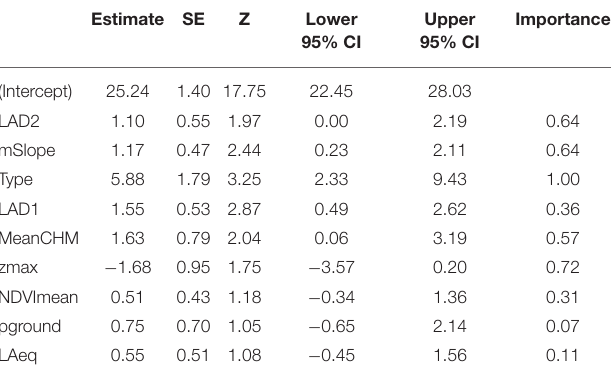
TABLE 6 | Model Averaged Coefficients for Vocal Deviation ∼ Ecological Variables. Estimate